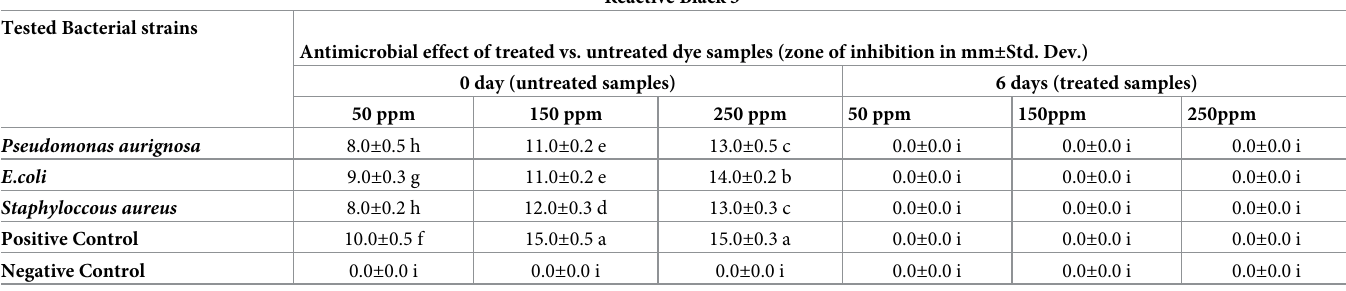
Table 4. Antimicrobial activity of treated and untreated Reactive black 5 samples against bacteria.